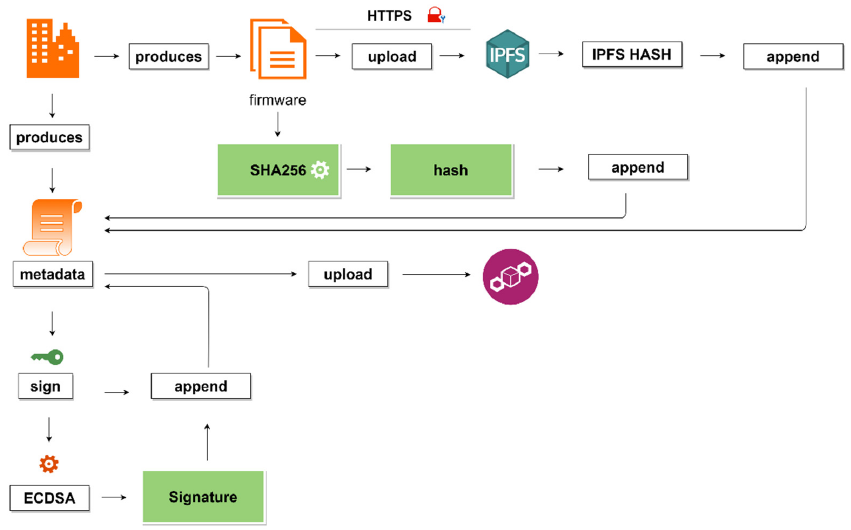
Figure 5. Firmware Distribution Process.